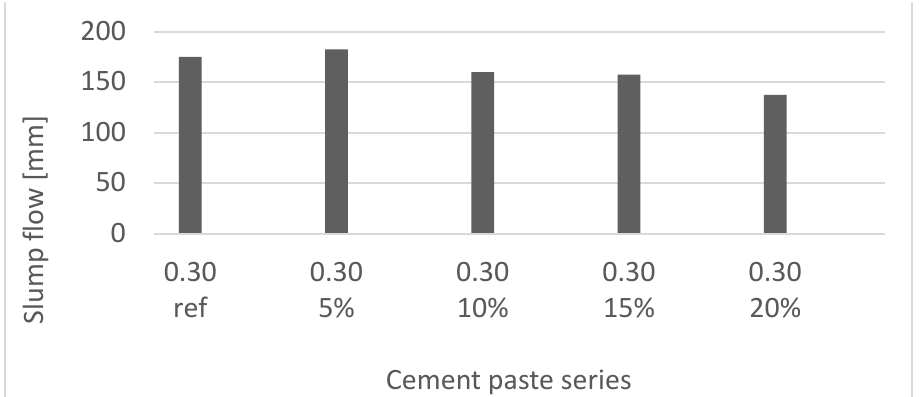
Figure 2. Effects of cement substitution with spent FCC catalyst on the slump flow of cement paste mixes.